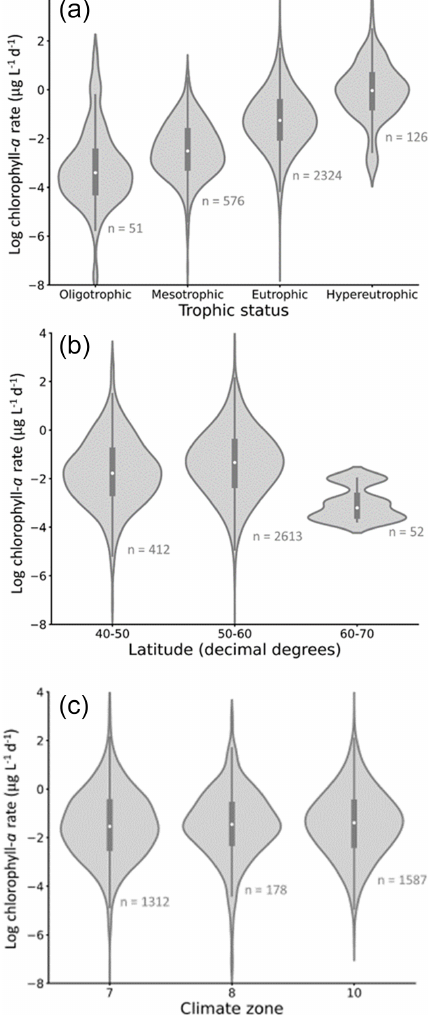
Figure 7. Rate of chlorophyll-a increase (RCI) trends in the dataset, grouped by (a) trophic status, (b) latitude, and (c) climate zone. Lakes of a higher trophic status have a higher mean RCI, while lakes at higher latitudes have lower RCI (with considerable over- lap between all categories). Grouping by climate zone shows mini- mal effect on RCI. The number of lakes represented by each violin is shown in grey text on the panels. Climate zones are as follows: 7 = cold and mesic; 8 = cool, temperate, and dry; 10 = warm, tem- perate, and mesic. White circles indicate the mean value for each violin.